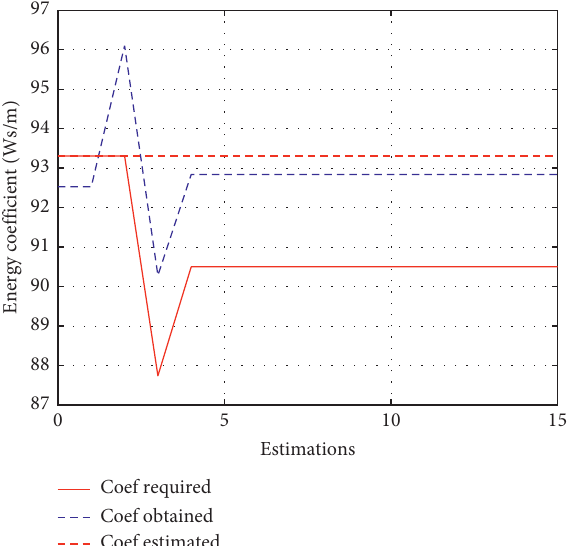
Figure 12: Estimation of energy per kilometer variation.